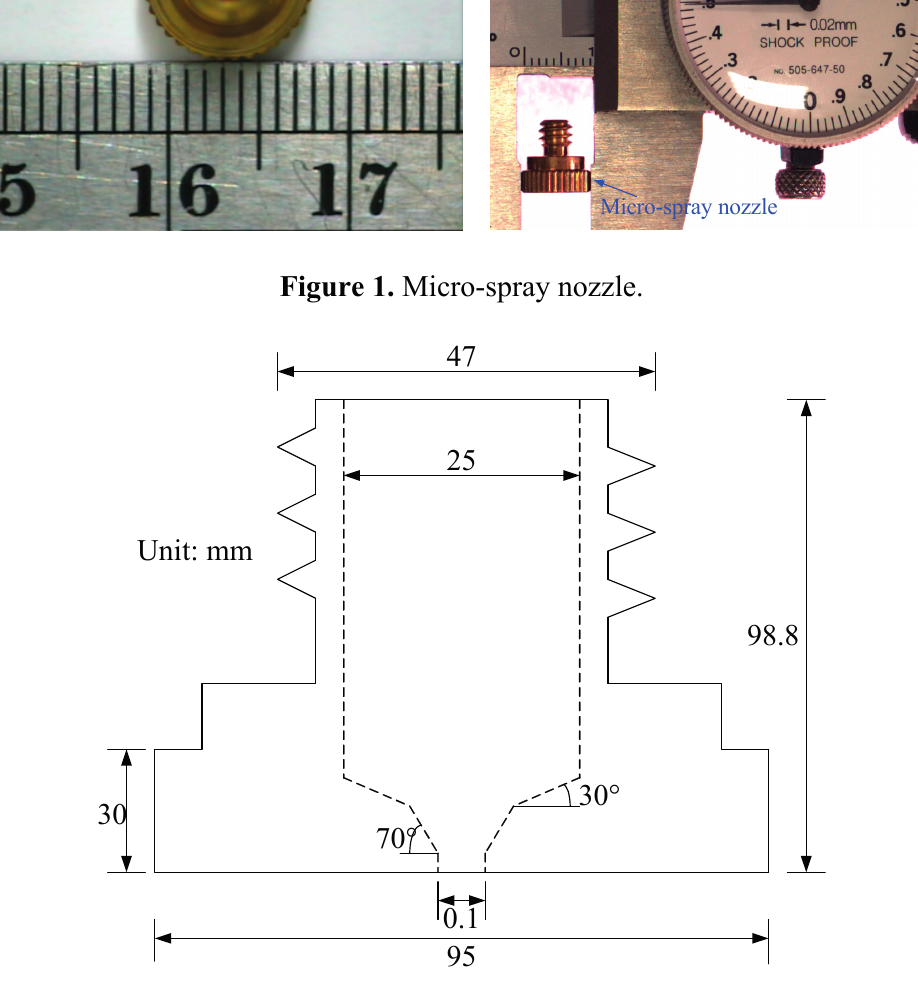
Figure 2. The profile of the micro-spray